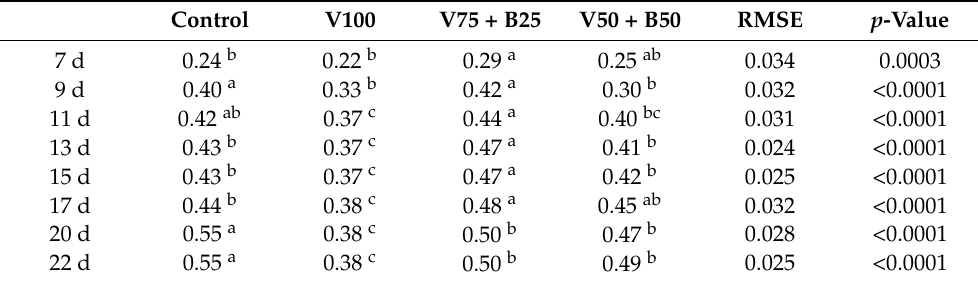
Table 4. Body thickness (cm) of black soldier fly larvae from 7 to 22 days of age. Control V100